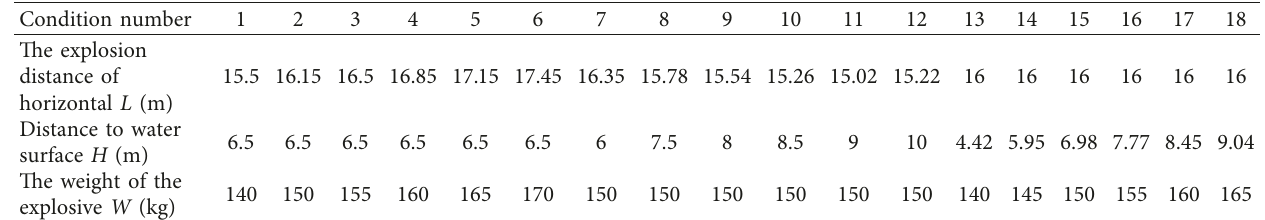
Table 4: The starboard condition parameters under the same shock factor.